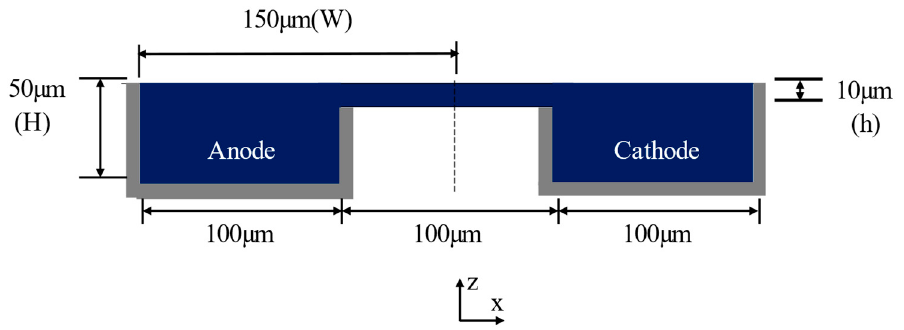
Figure 2. Cross-section of the single-bridge channel proposed by Montesinos et al. [17] (grey regions indicate electrodes).